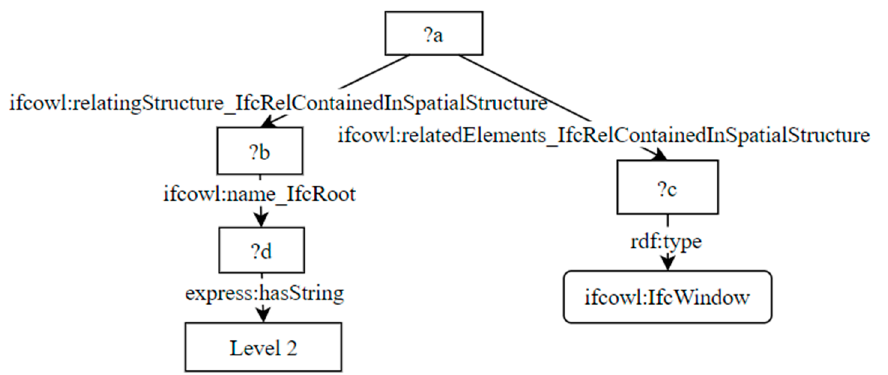
Figure 8. The structure of the shortest path with query variables.